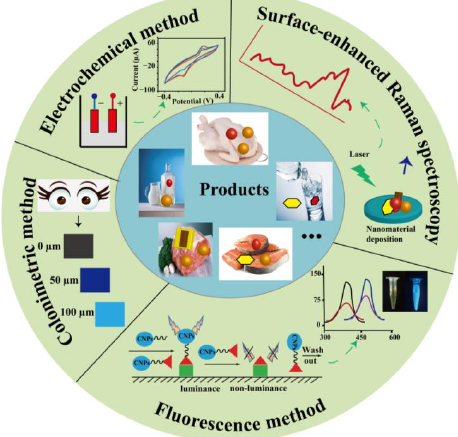
Figure 1. Nanomaterial-based methods for the determination of antibiotics.